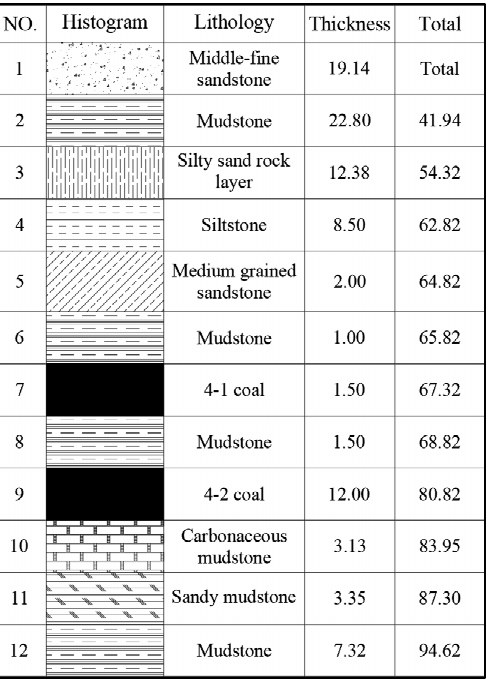
Figure 4. Schematic diagram of the location of top coal gangue in working face 42,018. 3. Analysis of the Crushing Mechanism of Top Coal Containing Gangue 3.1. Mechanical Analysis of the Top Coal Crushing Mechanism The abutment pressure fracturing caused by the accumulation of small cracks in the initial coal mass during the mining process is constantly densified, enlarged, and dam ‐ aged, resulting in caving and the release of top coal in fully mechanized caving faces. The coal mass damage principle is as follows: If the internal fissures of the top coal are highly developed and the degree of damage is quite high, then the more uniform the block size of the top coal broken and the better the top coal cavability, from the initial micro ‐ fracture damage to the local macro ‐ fracture damage, then to the overall macro ‐ fracture propaga ‐ tion through the damage. On the contrary, if the internal fracture extension of the top coal under the action of the abutment pressure is insufficient, the damage extent is small, and the size of the broken top coal is not uniform, and the top coal release will be poor, causing a small top coal recovery rate. During the progress of the fully mechanized caving face, the stress condition and damage change features of the top coal at the front and back of the working face can be classified into four regions (Figure 5).